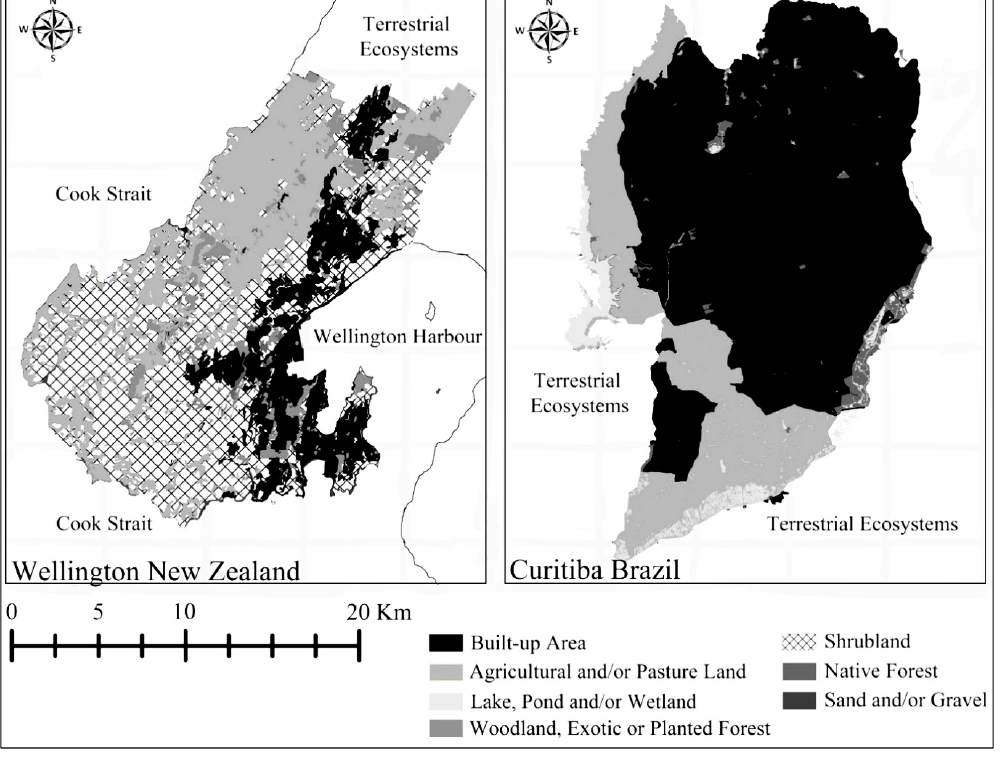
Figure 2. Land-cover types in Wellington and Curitiba. Table 5. The extent of land-cover types in Curitiba and Wellington.